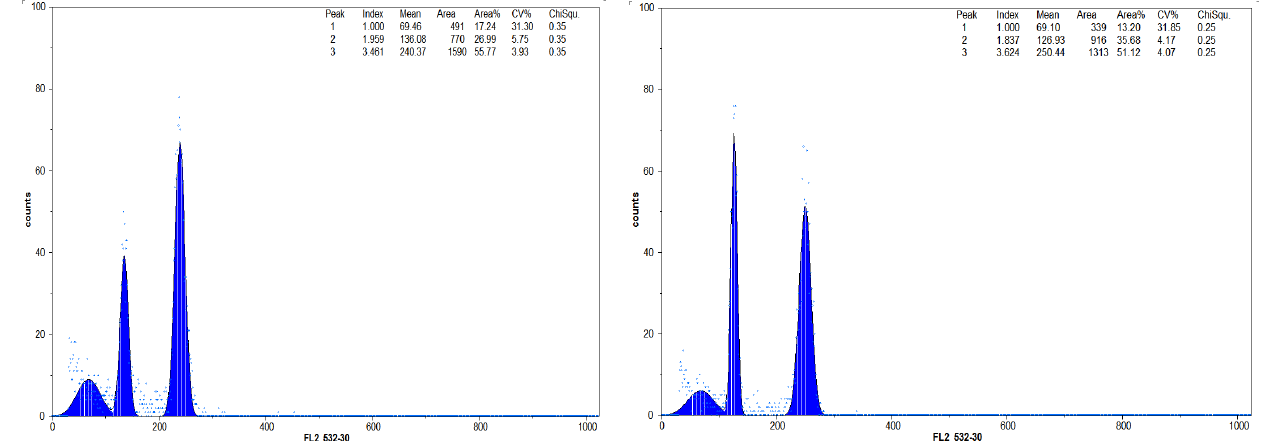
Fig. 2: Relative positions of the G1 peaks of ‘Erdemli’ banana clone and rice (fırst peak)